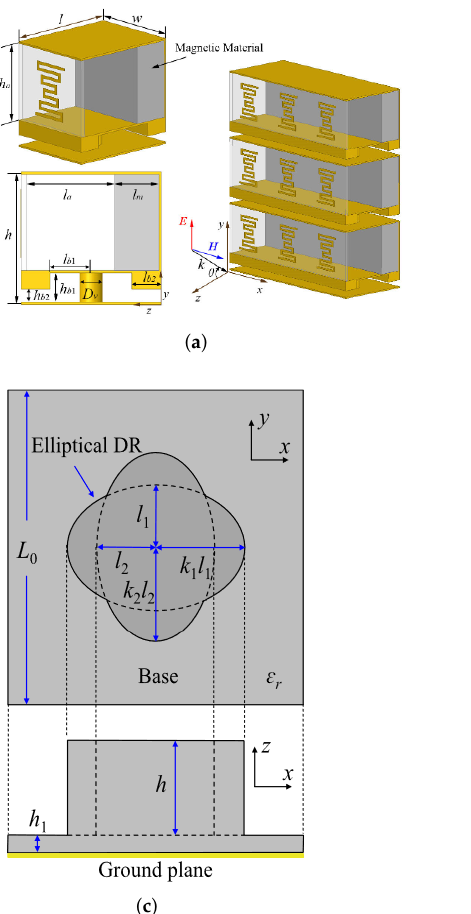
Figure 3. ( a ): One of the cells conceived for rasorbers. This one was reported in [156]. ( b ): Full-metal reflectarray prototype reported in [164]. ( c ): Fully dielectric reflectarray prototype reported in